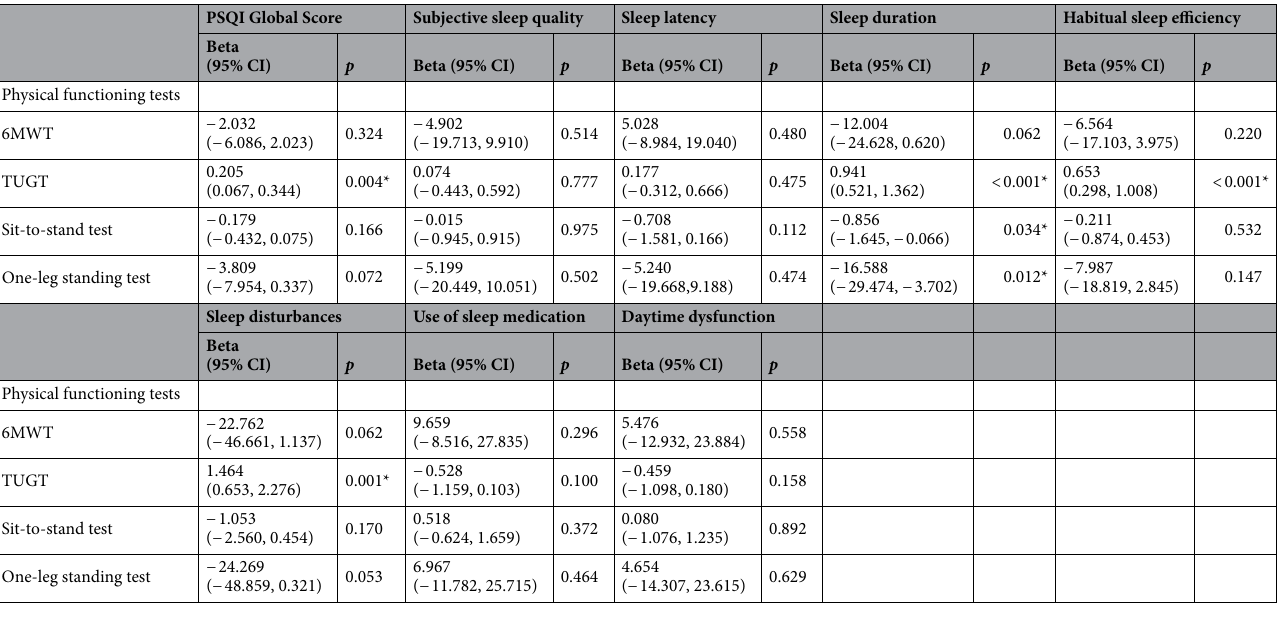
Table 2. Univariable regression model for subjective sleep measures with physical performance. * p <